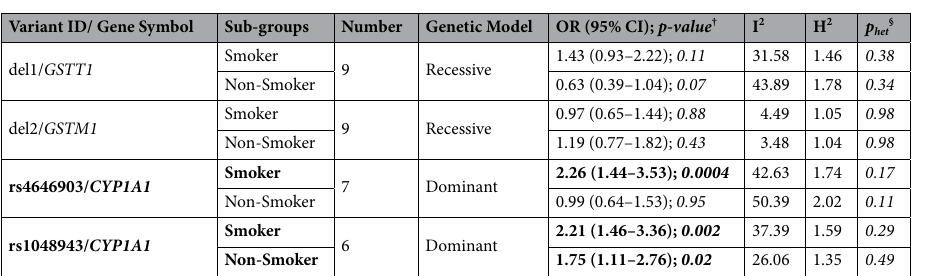
Table 4. The results of the subgroup analysis stratified by smoking status. † p-value < 0.05*, 0.01**, 0.001***, OR, Crude Odds Ratio, 95% CI, 95% Confidence Interval, I 2 and H 2 are. measures of heterogeneity. § p Het < 0.1 (Cochran’s Q test). Significant associations are depicted in